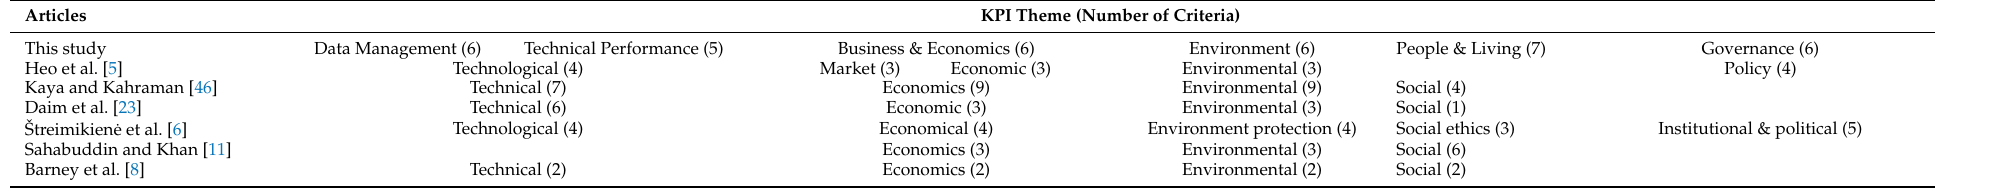
Table 4. Alignment of KPI themes and criteria with the existing